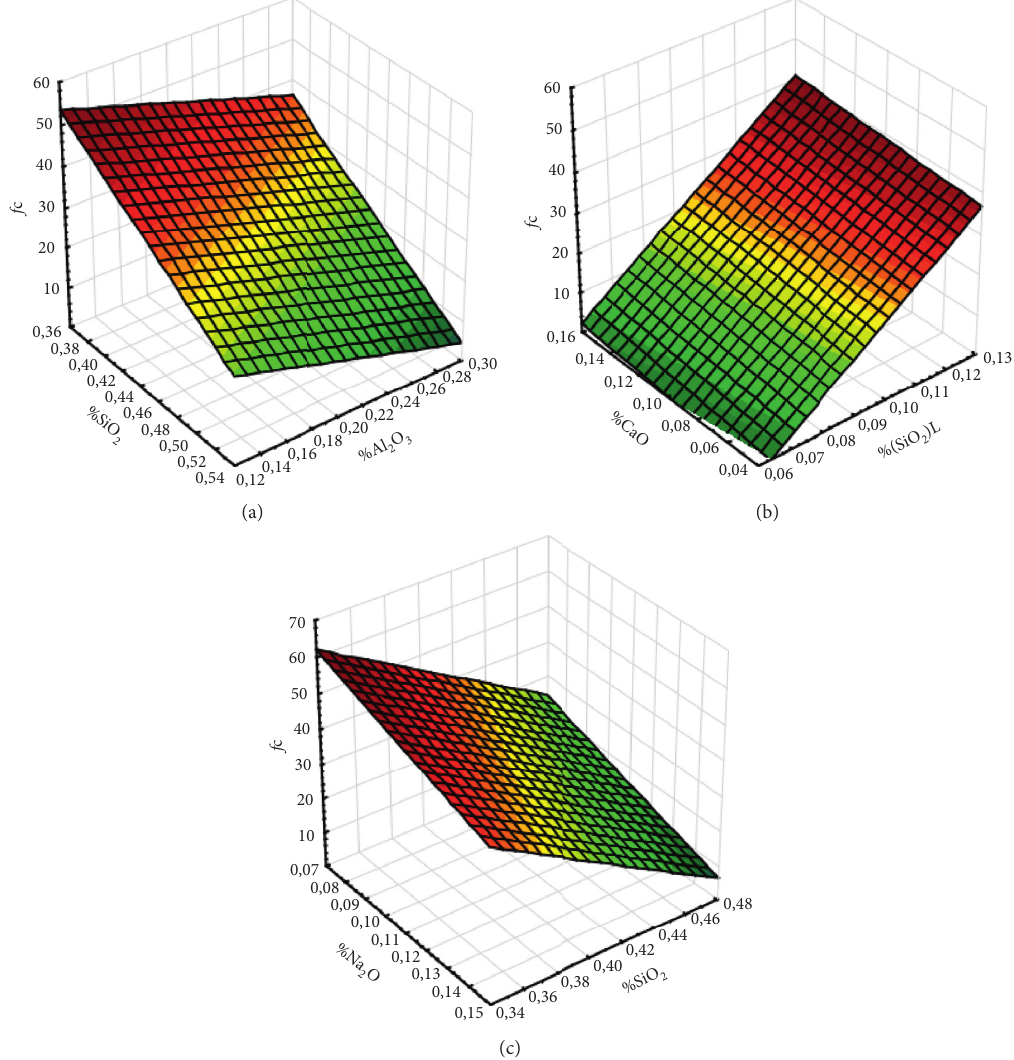
Figure 10: 3D surface plot of the molar fractions with respect to the compressive strength: (a) %SiO (c) %Na 2 O vs %SiO 2 .